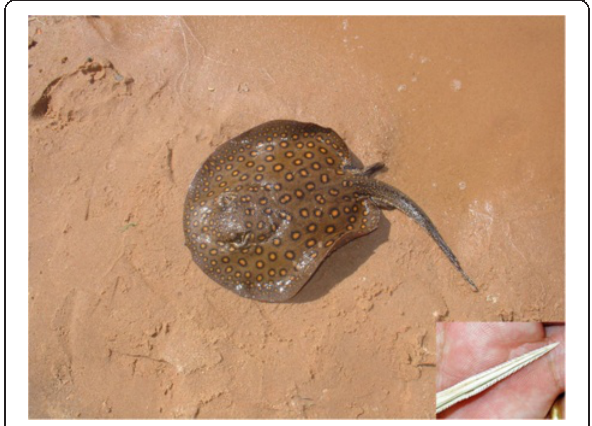
Figure 5 Potamotrygon motoro , the most common species of freshwater stingray. This ray is found in most regions of Brazil. Photo by: Vidal Haddad